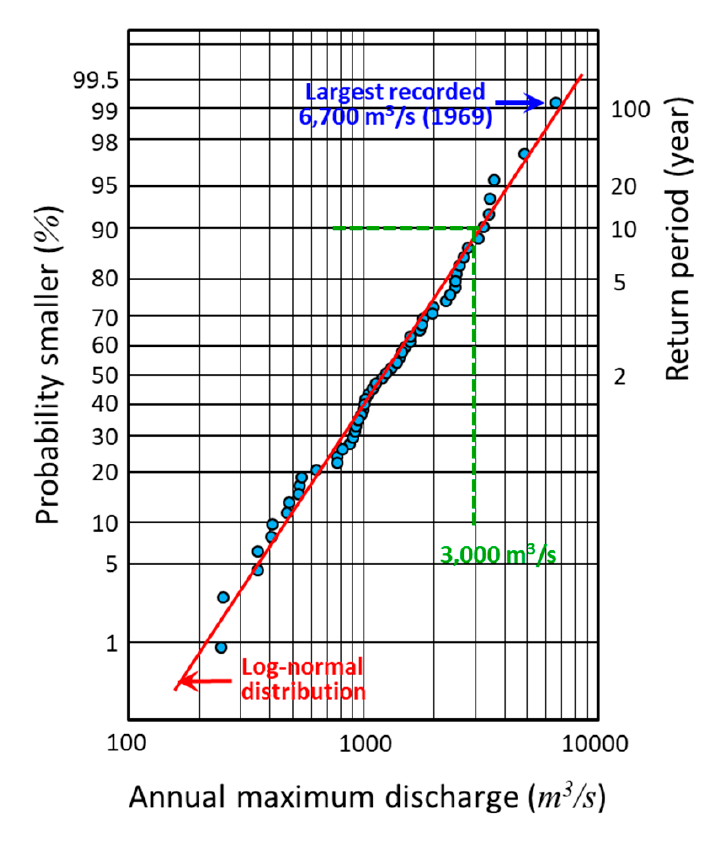
Figure 11. Probability plot of annual maximum discharge. Table 1. Case of numerical simulation.